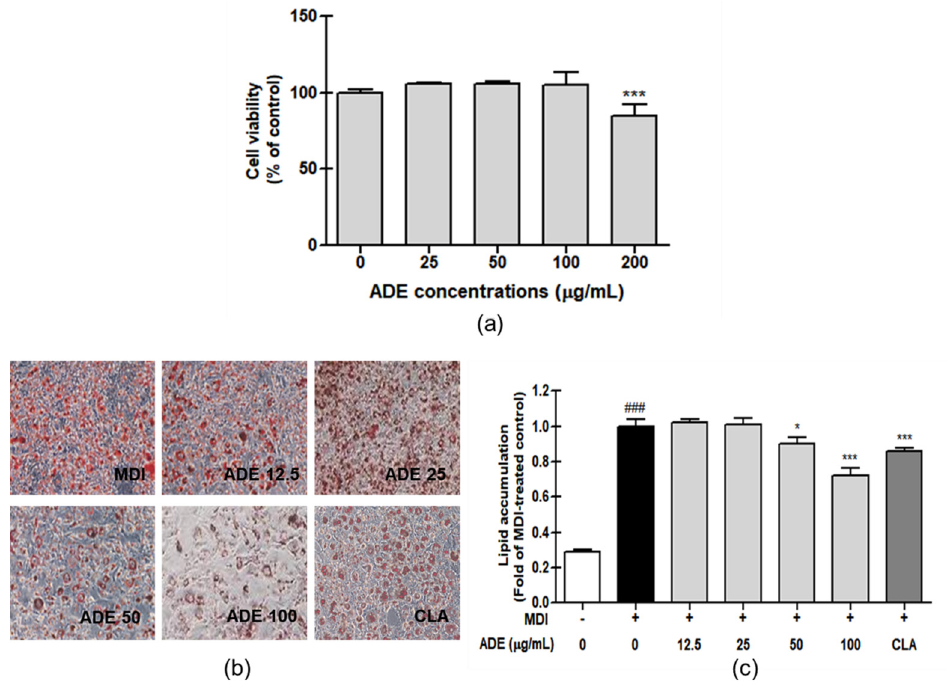
Figure 1. Cell viability ( a ) and inhibition of lipid droplet accumulation by ADE on microscopy ( b ) quantifications ( c ) of 3T3-L1 adipocytes. Di ff erentiating cells were treated every 2 days with and quantifications ( c ) of 3T3-L1 adipocytes. Differentiating cells were treated every 2 days with extracts (25–100 μ g/mL) for 8 days in adipocyte-induction media. Conjugated linoleic acid (CLA) (50 μ M) was a positive control. All values are means ± SD ( n = 3). ### p < 0.001 vs. non-MDI treated